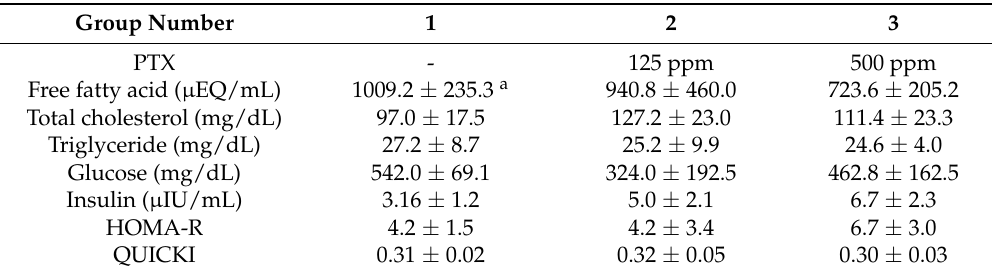
Table 2. Serum parameters of the experimental